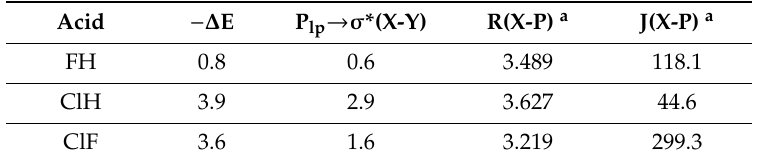
Figure 7. Equilibrium structures D for ( a ) FH:P(CH) 3 , ( b ) ClH:P(CH) 3 , and ( c ) FCl:P(CH) 3 . Table 5. Binding energies ( − ∆ E, kJ mol − 1 ), intermolecular distances (R, Å), charge-transfer energies (CT, kJ mol − 1 ), and spin–spin coupling constants (J, Hz]) for complexes XY:P(CH) 3 isomers D .